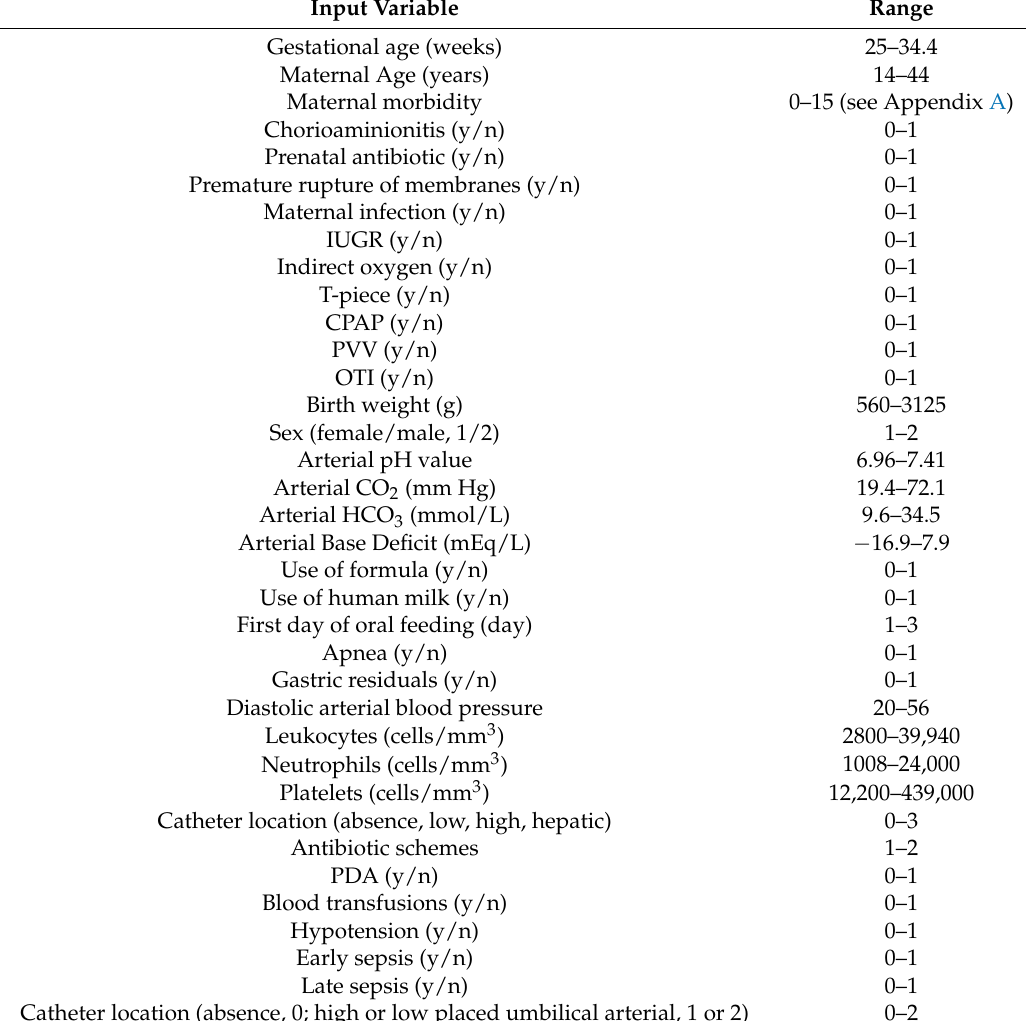
Table 4. Input range conditions in the IP ANN model at birth and during